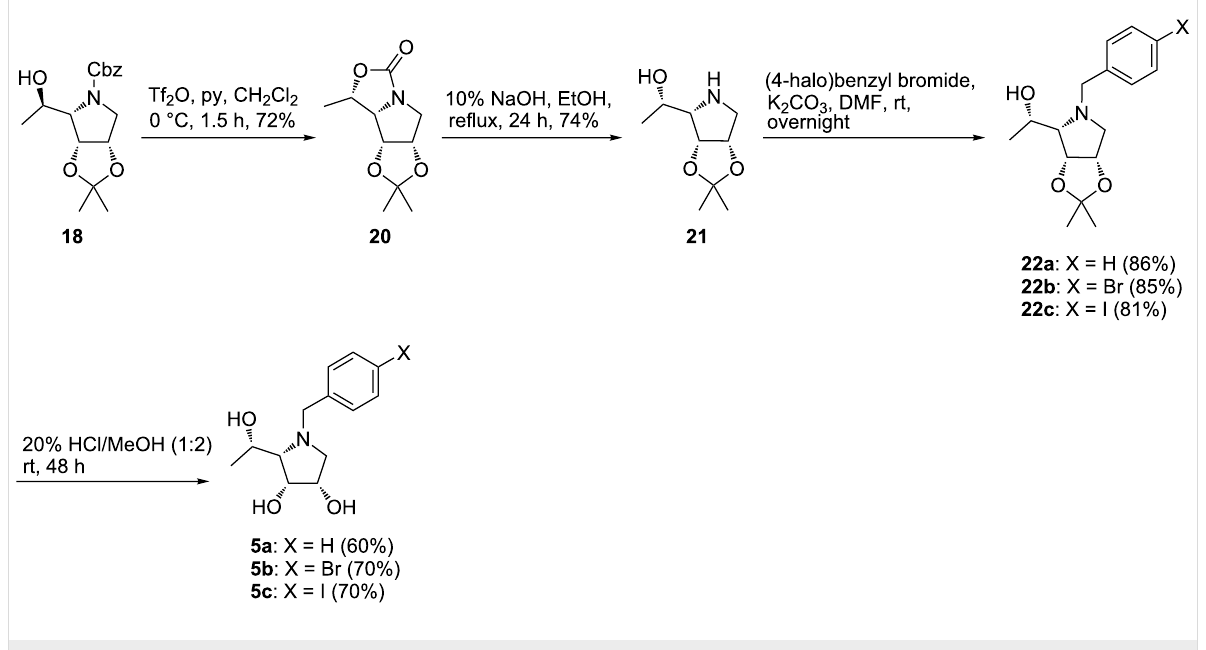
Scheme 4: Synthesis of pyrrolidines 5 .